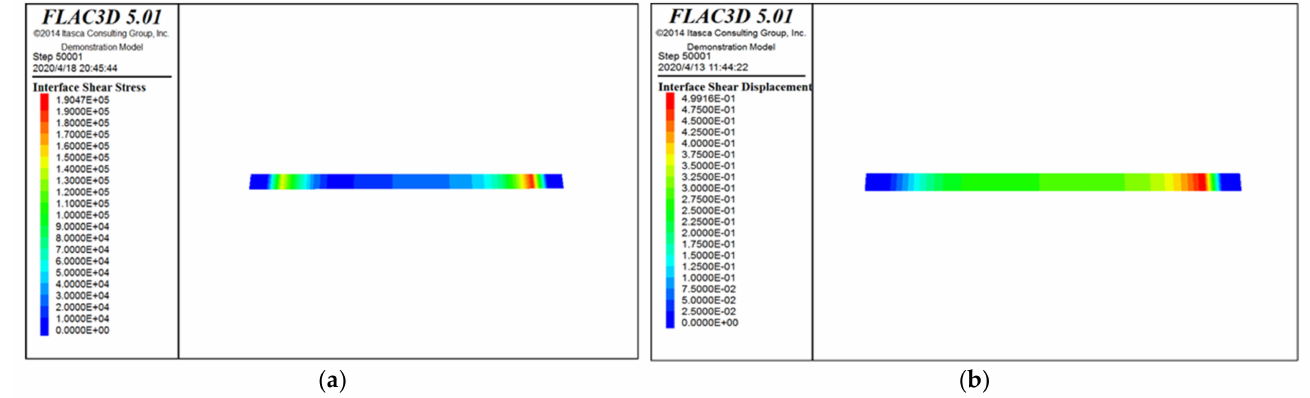
Figure 12. Stress and displacement cloud diagram on the shear surface. ( a ) Stress cloud diagram; and ( b ) displacement cloud